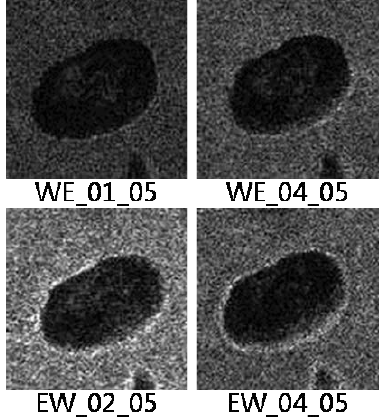
Figure 3. Blocks on rectified